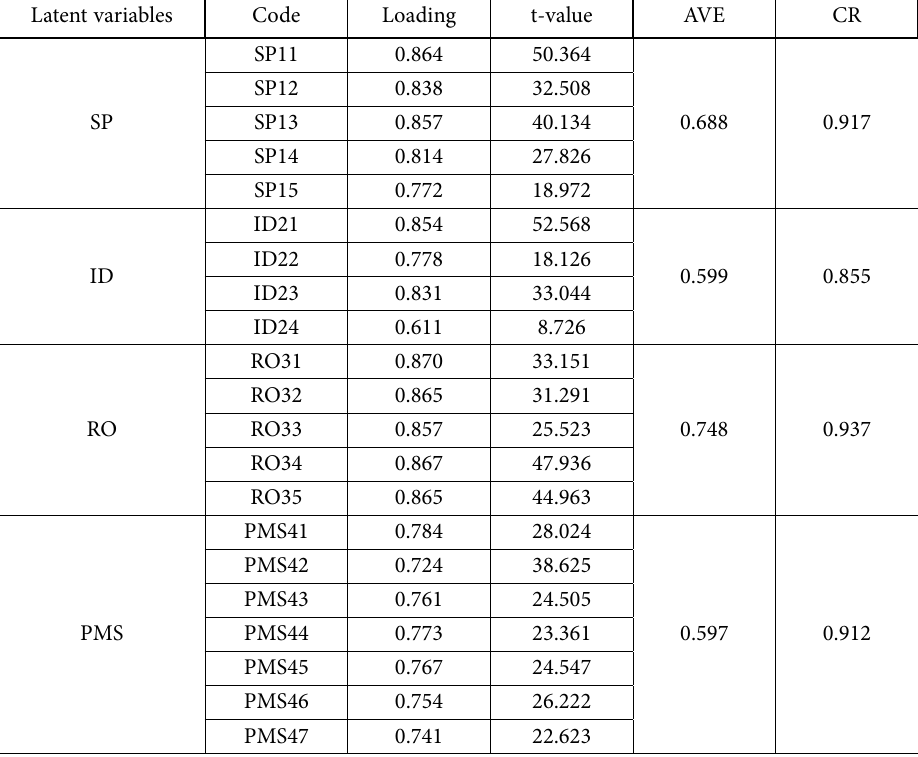
Table 7. Measurement model